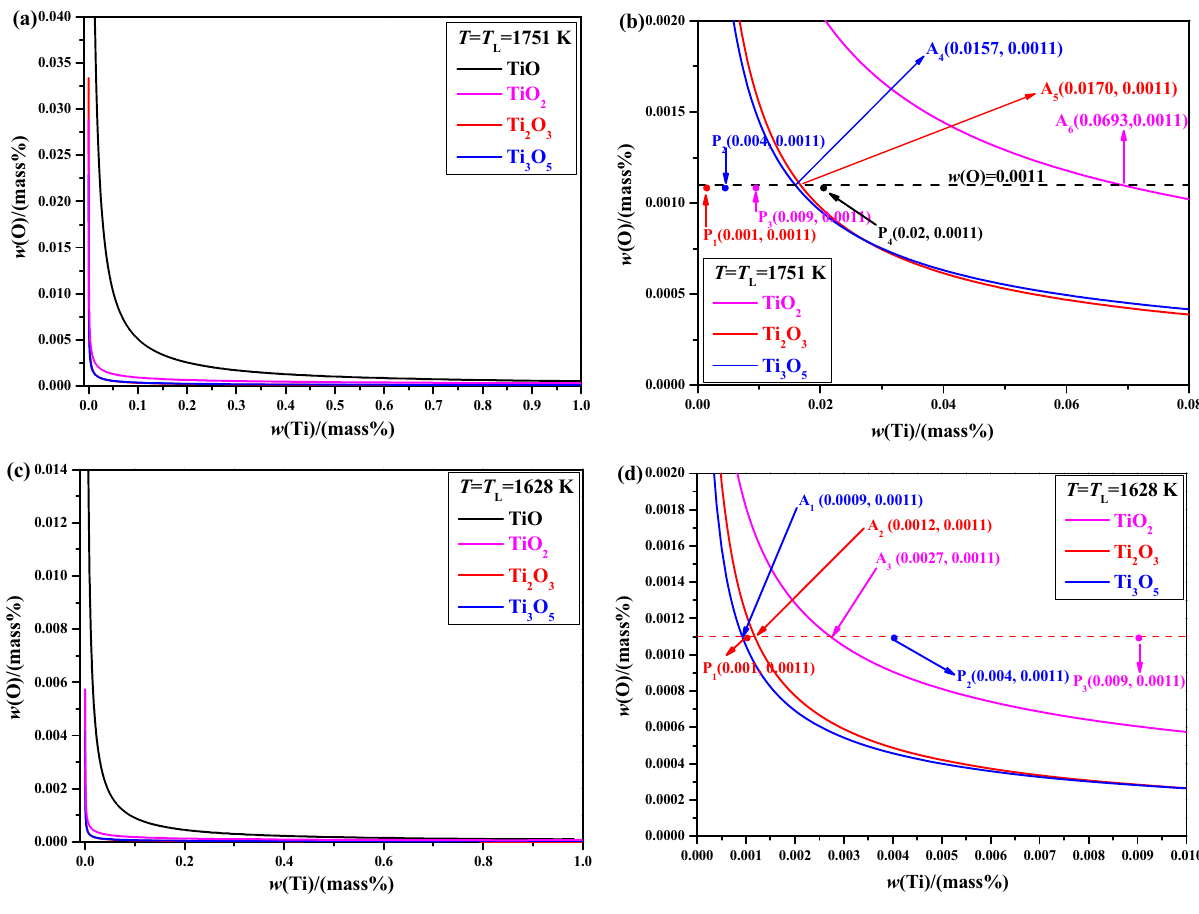
Figure 9: Ti – O equilibrium phase diagram at: ( a ) and ( b ) 1,751 K; ( c ) and ( d ) 1,628